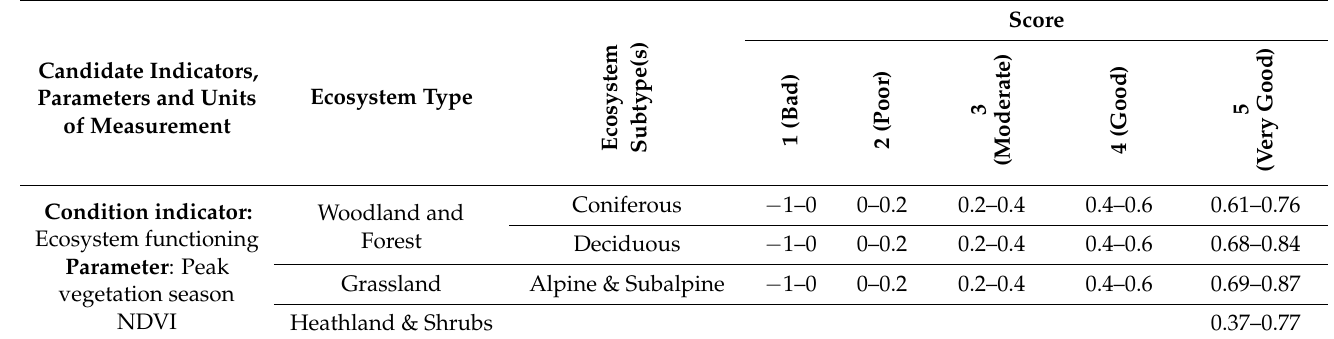
Table 3. Candidate indicator for remote ecosystem monitoring of the terrestrial ecosystems. Data source: Copernicus and Landsat remote sensing. Due to the very limited extent of heathland and shrubs, we were not able to derive reliable reference values of all reference states and left these reference values empty for further research and